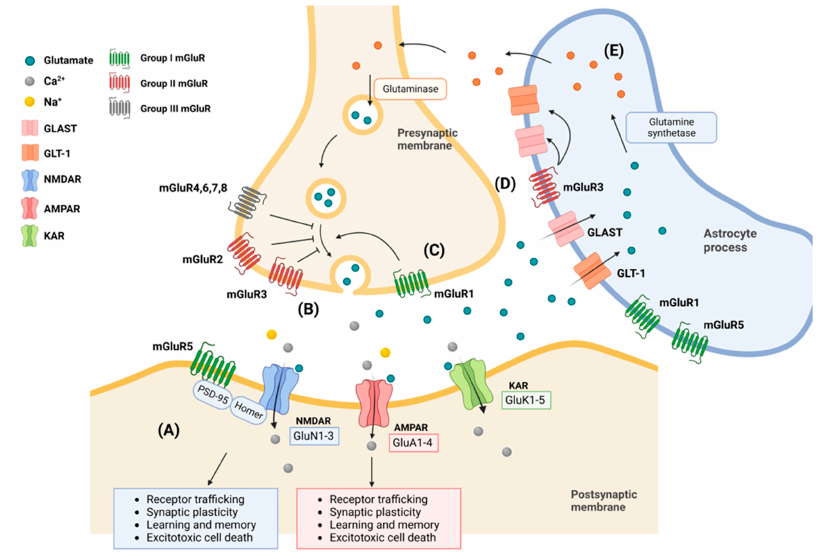
Figure 1. Mechanism and types of ionotropic and metabotropic glutamate receptors with associated proteins. ( A ) Ionotropic glutamate receptors are composed of four subunits and are structured sim-